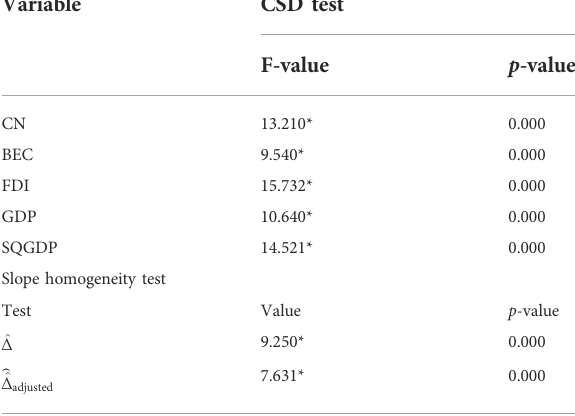
TABLE 2 CSD and slope homogeneity